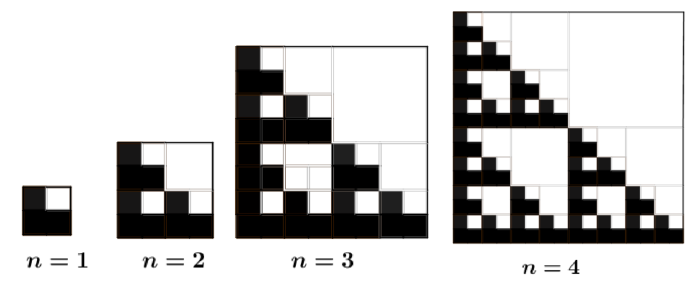
Figure 2. Matrices M P